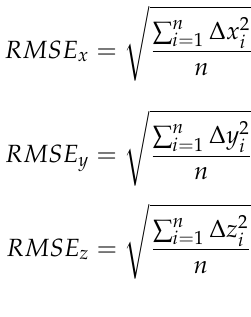
Table 2. Root mean square error of all 175 checkpoints recorded by a total station and an RTK GNSS terrestrial receiver. RMSE